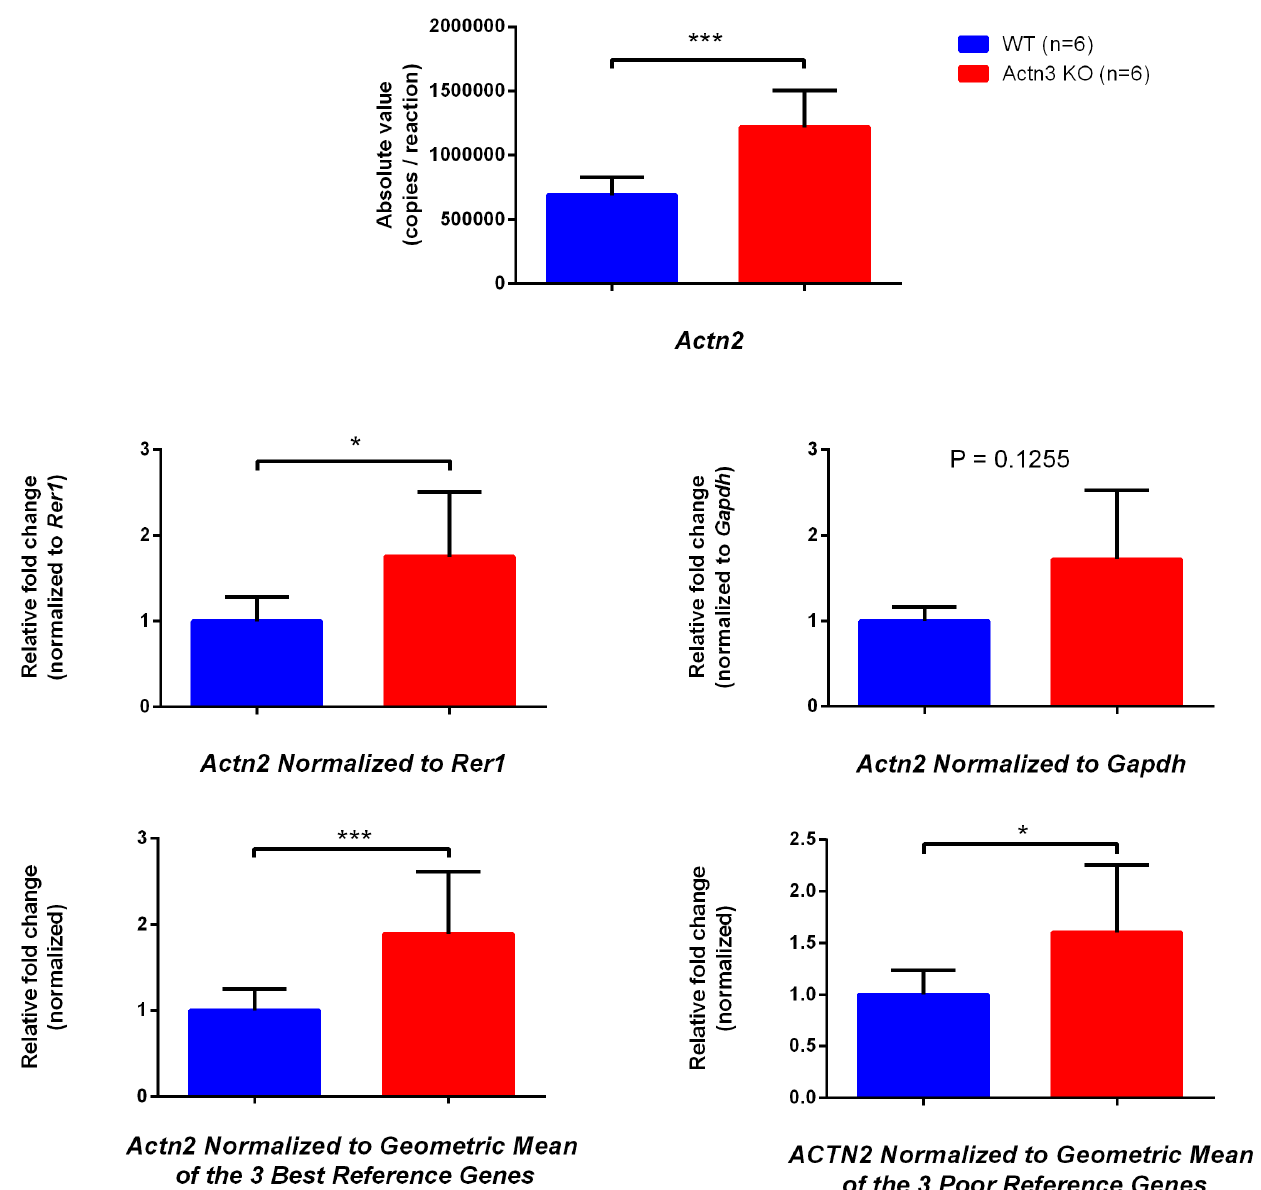
Figure 4. Reference gene selection affects interpretation of a result. Actn2 mRNA expression is increased approximately two-fold in Actn3 KO mouse by Absolute quantification (A). Comparisons of the outcome of normalisation to the best single reference gene ( Rer1 , B), a commonly used but, in this case poor reference gene ( Gapdh , C) the geometric mean of three top reference genes ( Rer1, Rpl27, Rpl41 , D), and to the three lowest reference genes ( Gapdh, Actb, Rn18s, E) are shown. (n=6 WT and n=6 Actn3 KO; + StDev; Mann-Whitney U-test *** P=0.004; *